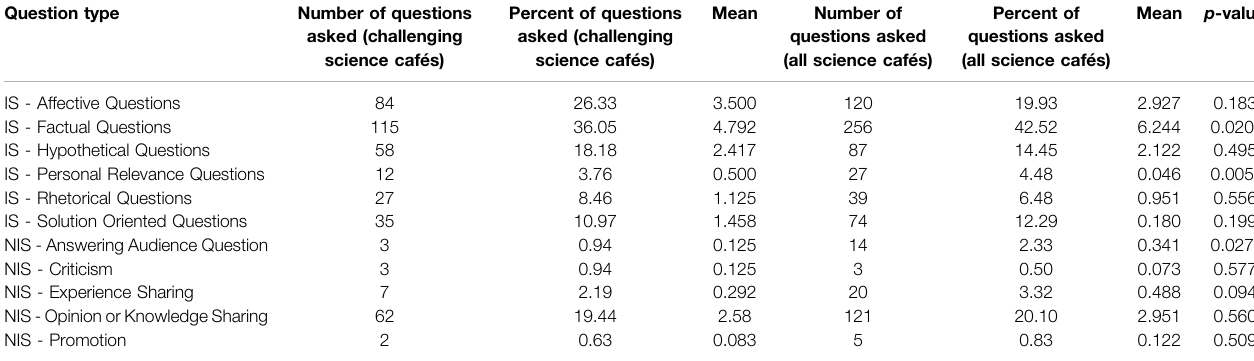
TABLE 1 | Comparison of question types at Science Café events featuring Challenging Topics ( n (cid:1) 24). Question